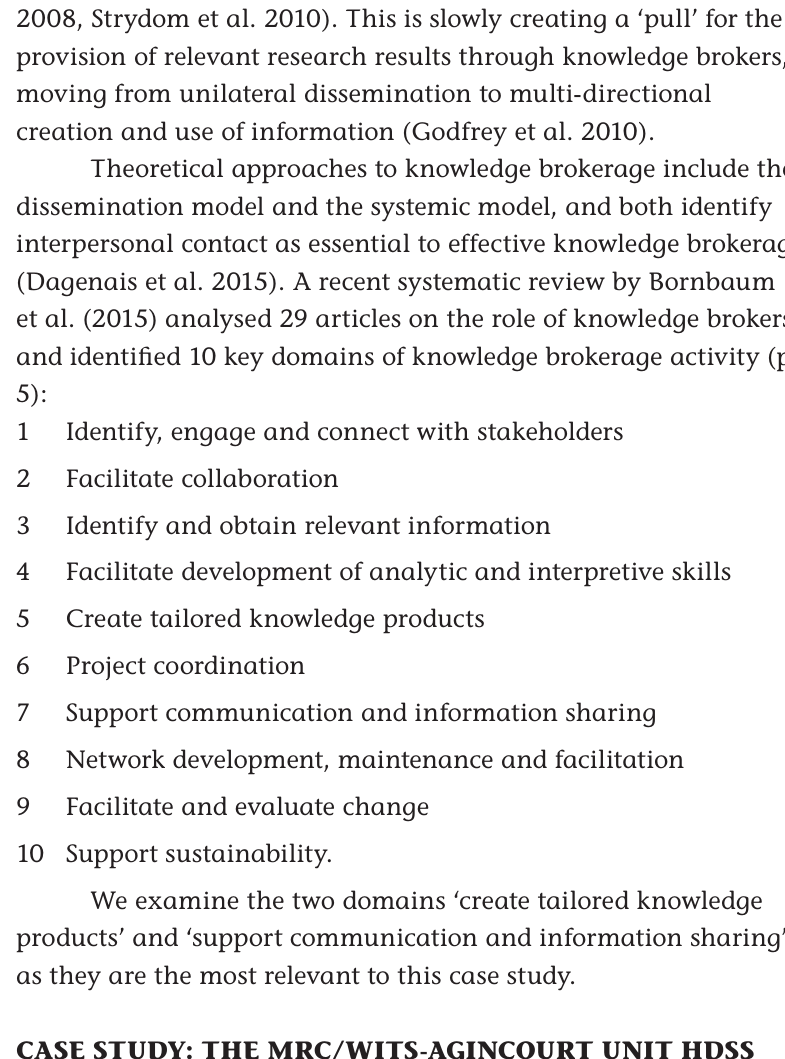
Figure 1: Location of